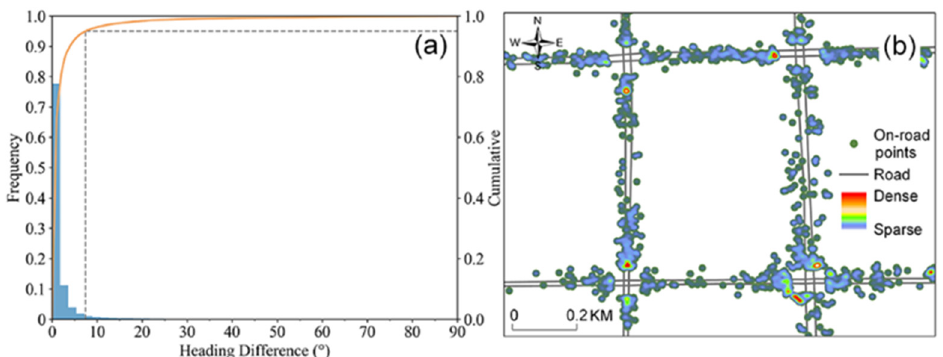
Figure 9. Differences between on-site headings and roadway directions: ( a ) shows the histogram and cumulative curve of headings differences and ( b ) shows the spatial distribution of on-road points with errors larger than 7°.